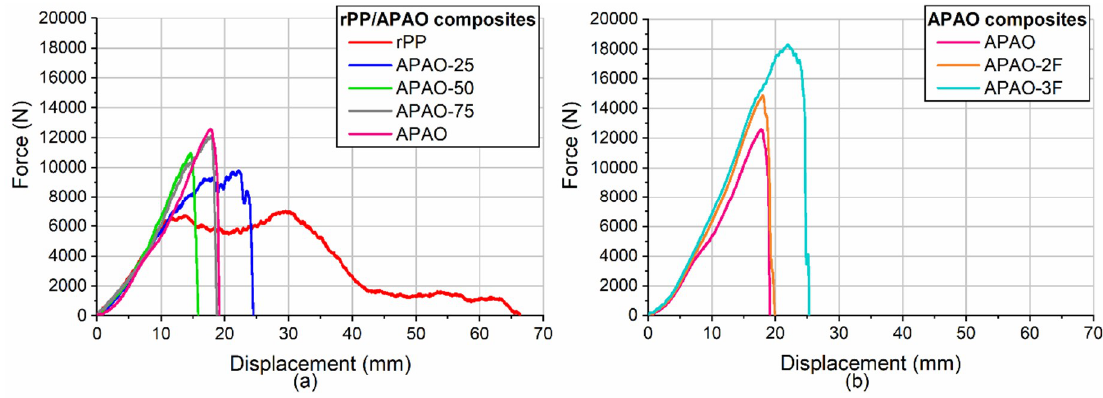
Figure 11. ( a ) typical IFWI curves of the composites with rPP / APAO blends as matrices and ( b ) the typical curves of the composites with increased fiber content.